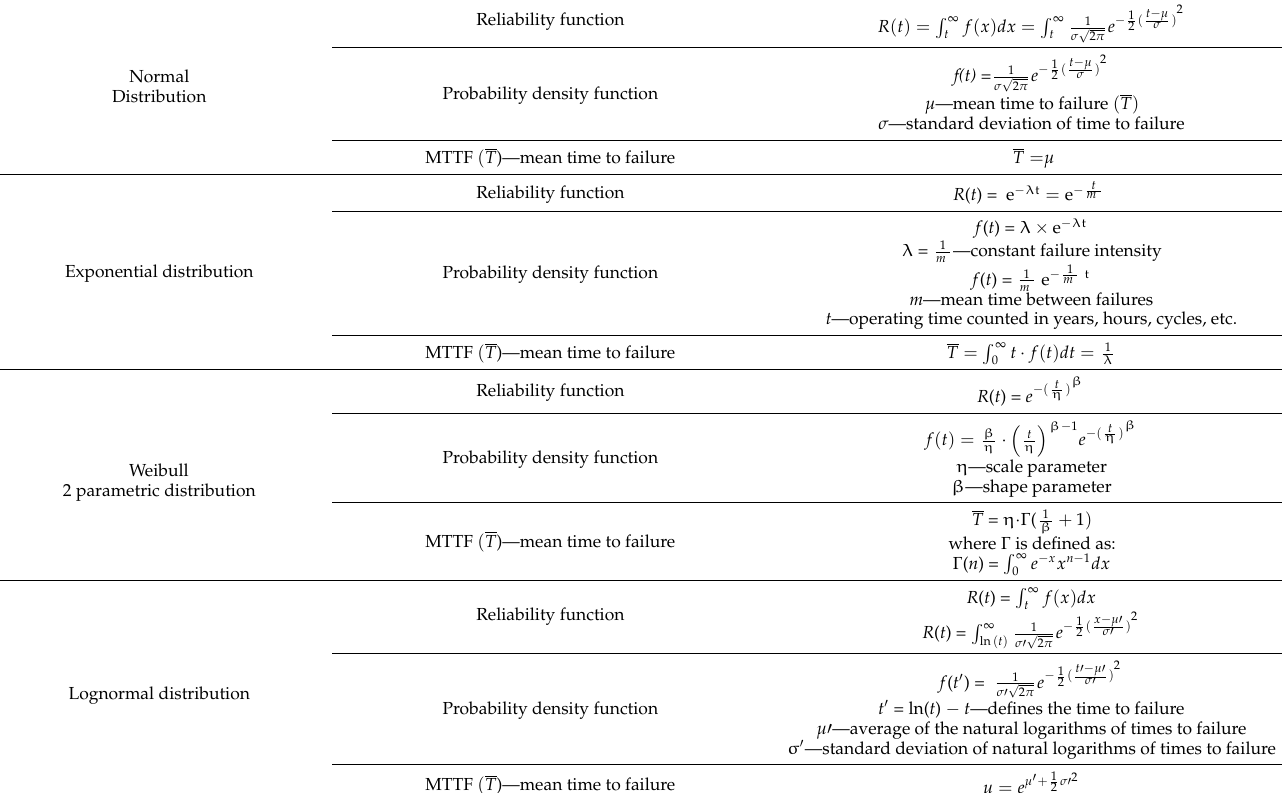
Table 1. Selected characteristics of distributions used in